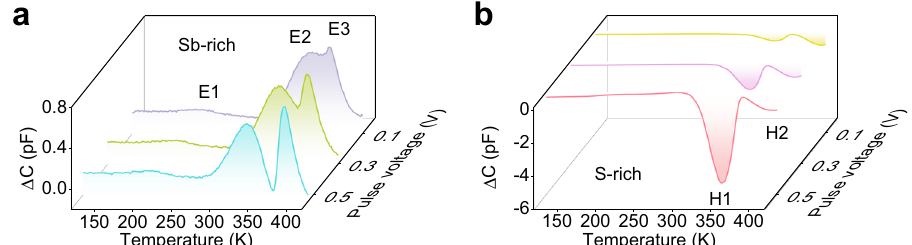
Fig. 4 Deep-level defects characterization. DLTS signals of Sb-rich ( a ) and S-rich Sb 2 S 3 fi lms ( b ) at pulse voltage ranging from 0.1 to 0.5 V, synergized with an identical pulse-width optical pulse. Δ C is the variation of capcitance.